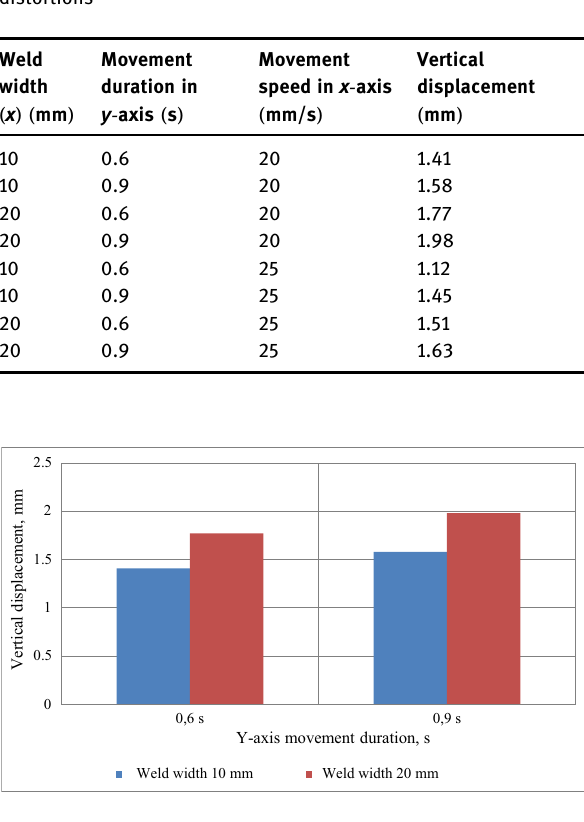
Table 5: Electrode weaving movement parameters and angular